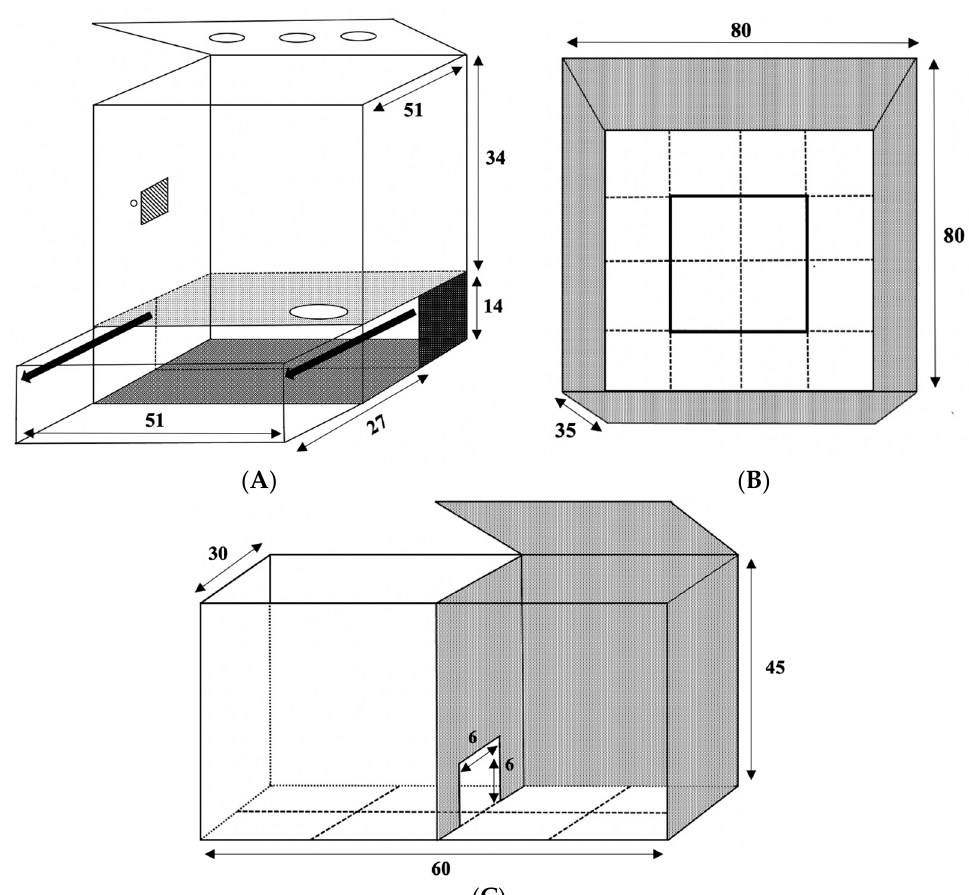
Figure 2. Visual representation (in centimetres) of ( A ) the semi-naturalistic housing cages with a burrow section that pulls open used in this experiment for offspring and their dam during lactation (PD 0 to PD 21), ( B ) The open field test, and ( C ) The light–dark box and predator odour exposure arena.